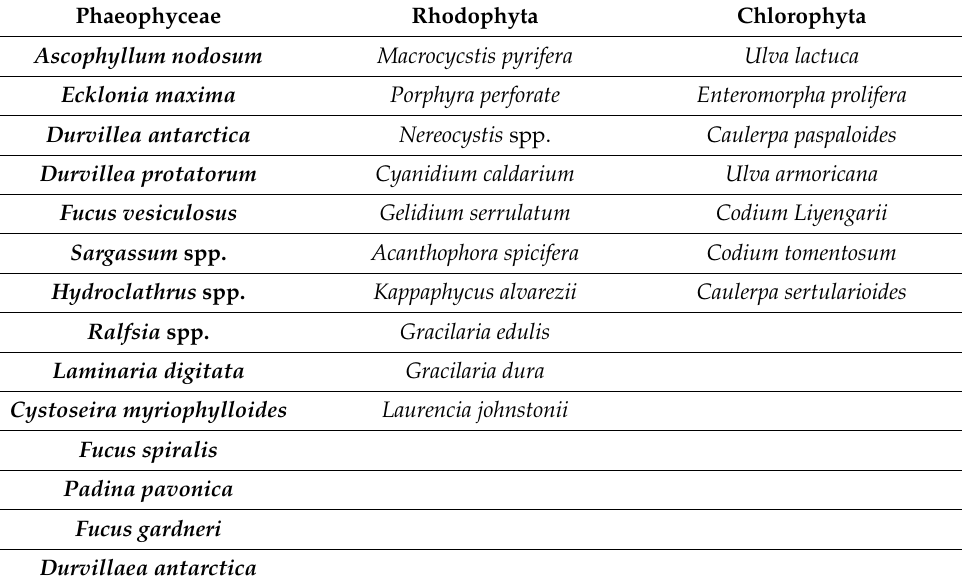
Table 1. List of important seaweed species with documented biostimulatory